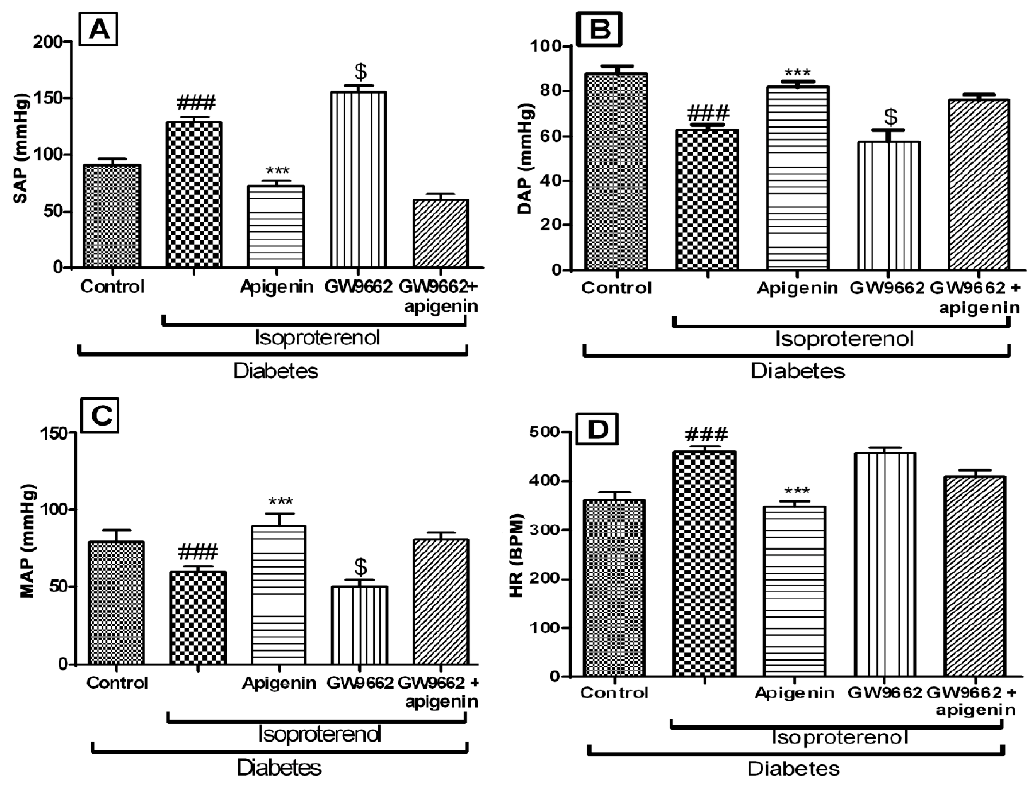
Figure 2. Effects of apigenin on hemodynamic parameters in STZ–isoproterenol-treated rats. ( A ) Systolic arterial pressure (SAP); ( B ) Diastolic arterial pressure (DAP); ( C ) Mean arterial pressure (MAP); ( D ) Heart rate (HR). The data are expressed as mean ± standard error mea (SEM). The significance was determined by one-way ANOVA followed by the Bonferroni’s post hoc test: *** p < 0.001 as compared to diabetic isoproterenol; ### p < 0.001 as compared to diabetic control; $ p < 0.001 as compared to diabetic isoproterenol + apigenin. BPM: Beats per minute.